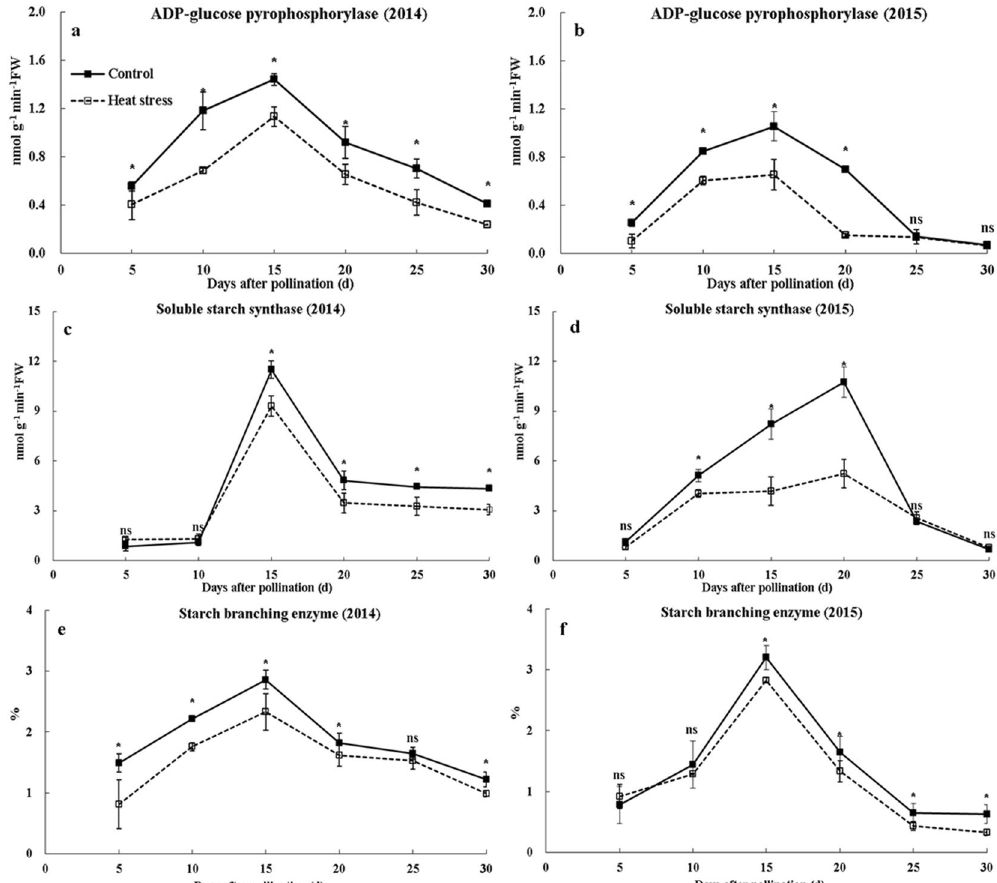
Figure 7. Activities of AGPase, SSS, and SBE during grain filling under ambient and high-temperature conditions. ( a , c , e and b , d , f ) indicate the activities of AGPase, SSS, and SBE in 2014 and 2015, respectively. Bars denote standard errors from three replicates, and one-way ANOVA was used to test for significance at p < 0.05